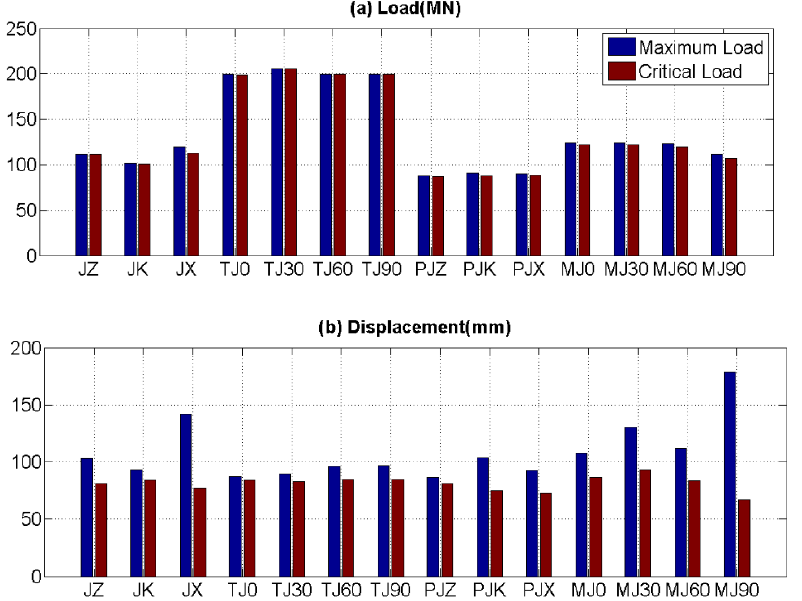
Figure 4. Comparison charts of all 14 jacket structures showing: ( a ) maximum and critical loads, and; ( b ) the corresponding displacements under unstable collapse and postbuckling analysis.